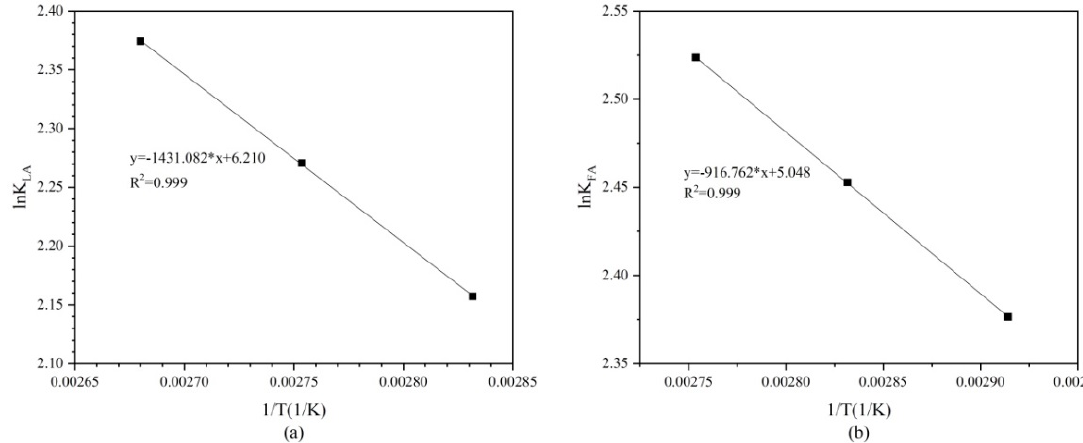
Figure 4. Reaction equilibrium equations of ( a ) LA and ( b ) FA.